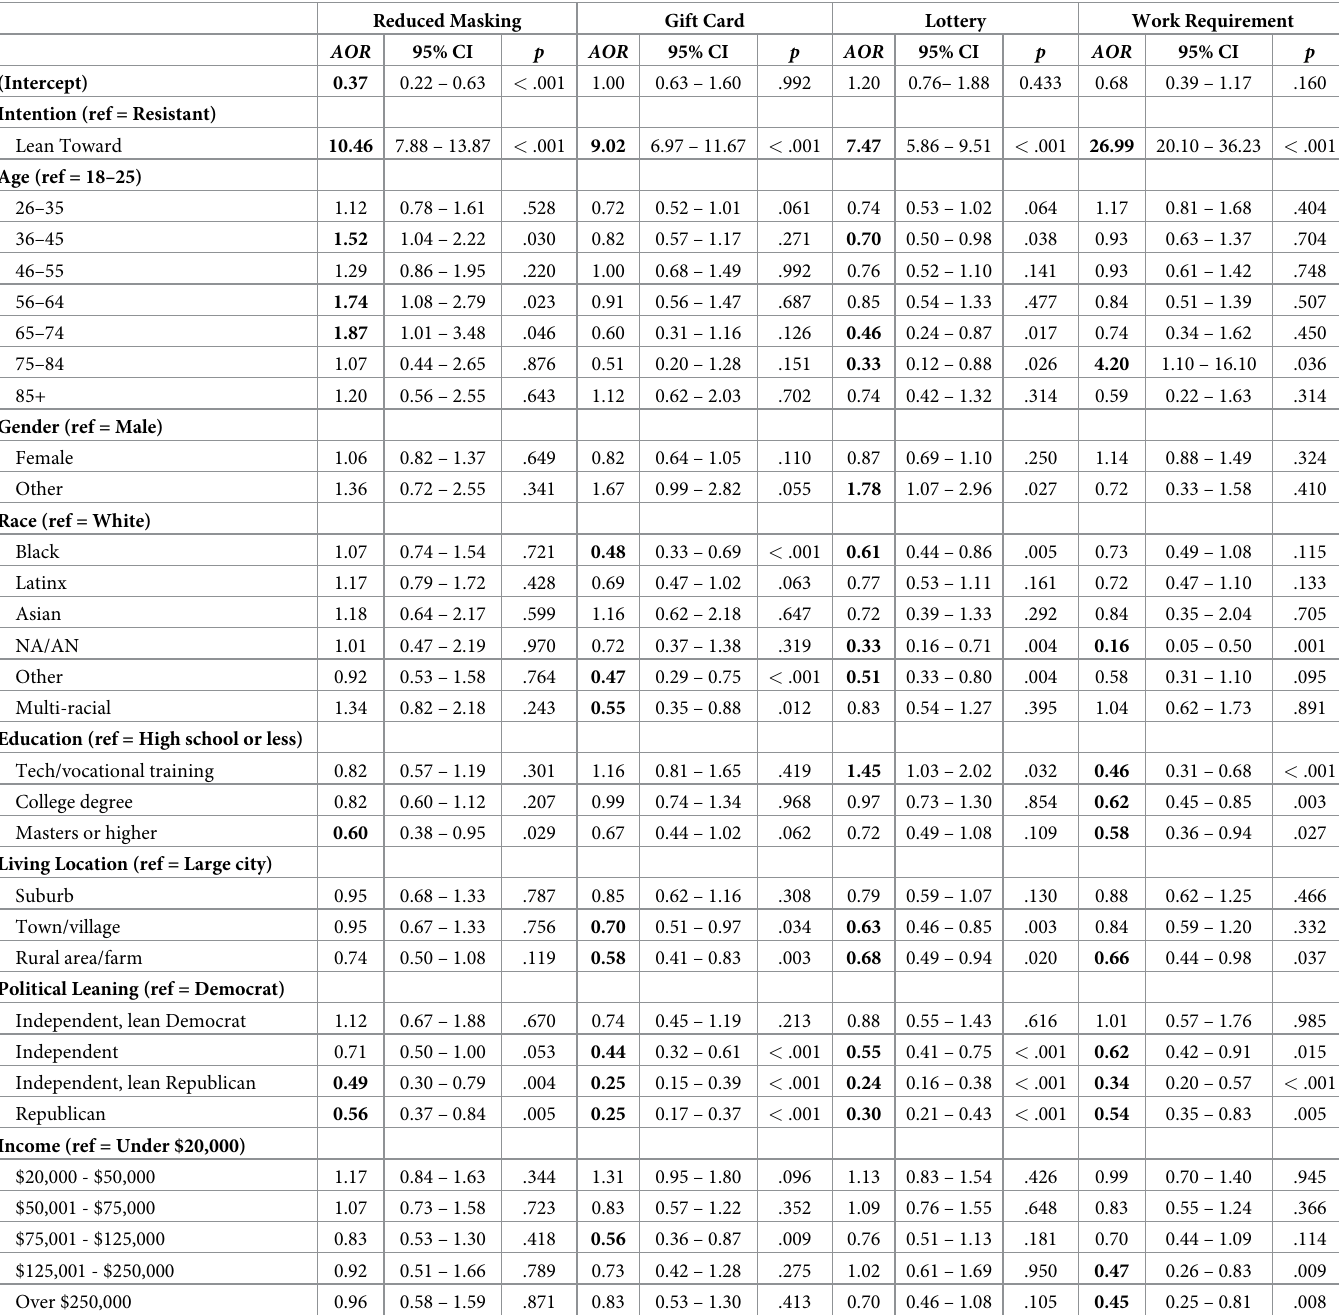
Table 4. Multinomial logistic regression analyses predicting impact on vaccination intention by demographics (more likely vs. less likely to get vaccinated comparison). Reduced Masking Gift Card Lottery Work